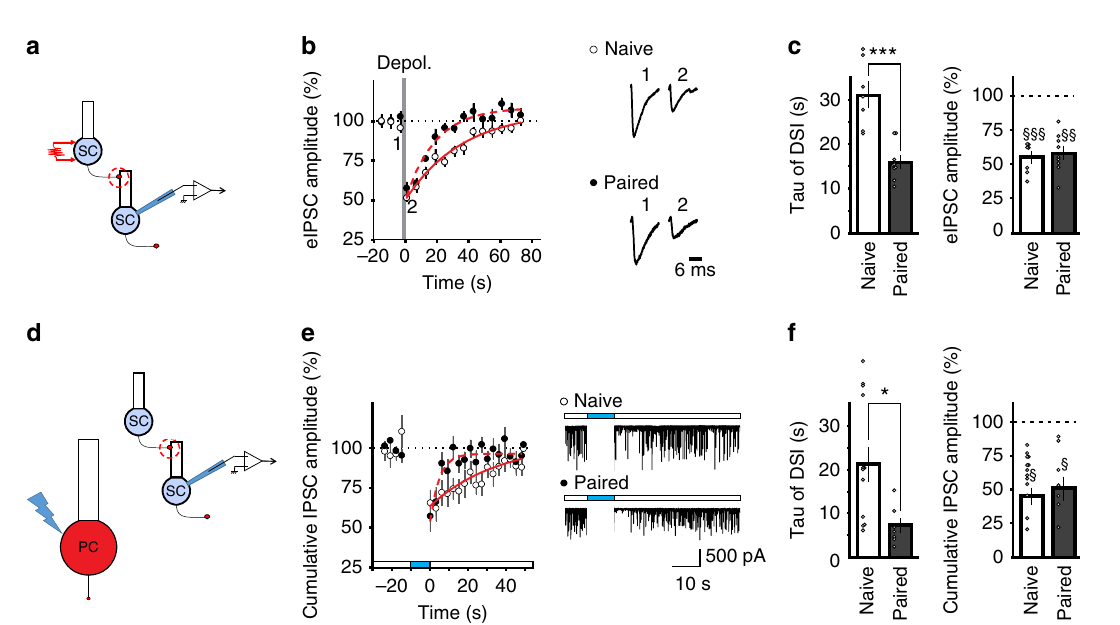
Fig. 2 Fear conditioning accelerates the recovery of depolarization-induced suppression of inhibition (DSI). a – c Depolarization of stellate cells induced suppression of evoked IPSCs. a Schematic of the experimental procedure, b sample traces and time course of evoked IPSCs in stellate cells from naïve ( n = 7 cells, open circles) and conditioned (paired) mice ( n = 9 cells, fi lled circles). c Recovery time constant of DSI and peak depression (naïve, n = 7 cells; paired, n = 9 cells). d , e Heterosynaptic DSI. Spontaneous IPSCs were recorded in stellate cells from L7::ChR mice and photostimulation of Purkinje cells for 10 s induced a decrease in sIPSCs. d Schematic of the experimental procedure, e examples and averaged time courses of cumulative IPSC amplitude in stellate cells from naïve mice ( n = 13 cells) and conditioned mice ( n = 7 cells, 15 h after fear conditioning). Best- fi t exponential curves for the recovery phase: solid (naïve) and dashed (paired) red lines. f Recovery time constant and peak depression of heterosynaptic DSI (naïve, n = 13 cells; paired, n = 7 cells). Group comparisons of DSI recovery time in c and f were obtained with two-sided unpaired t -tests (*, P < 0.05; ***, P < 0.001). Effects of depolarization of MLIs and PCs on eIPSCs ( c ) and cumulative sIPSC ( f ) amplitudes, respectively, were assessed using two-sided paired t -tests (§, P < 0.05; §§, P < 0.01; §§§, P < 0.001). Data in b , c , e , and f are presented as mean values± SEM. Statistical analysis and P values can be found in Supplementary Table 4 and original data in the Source Data fi